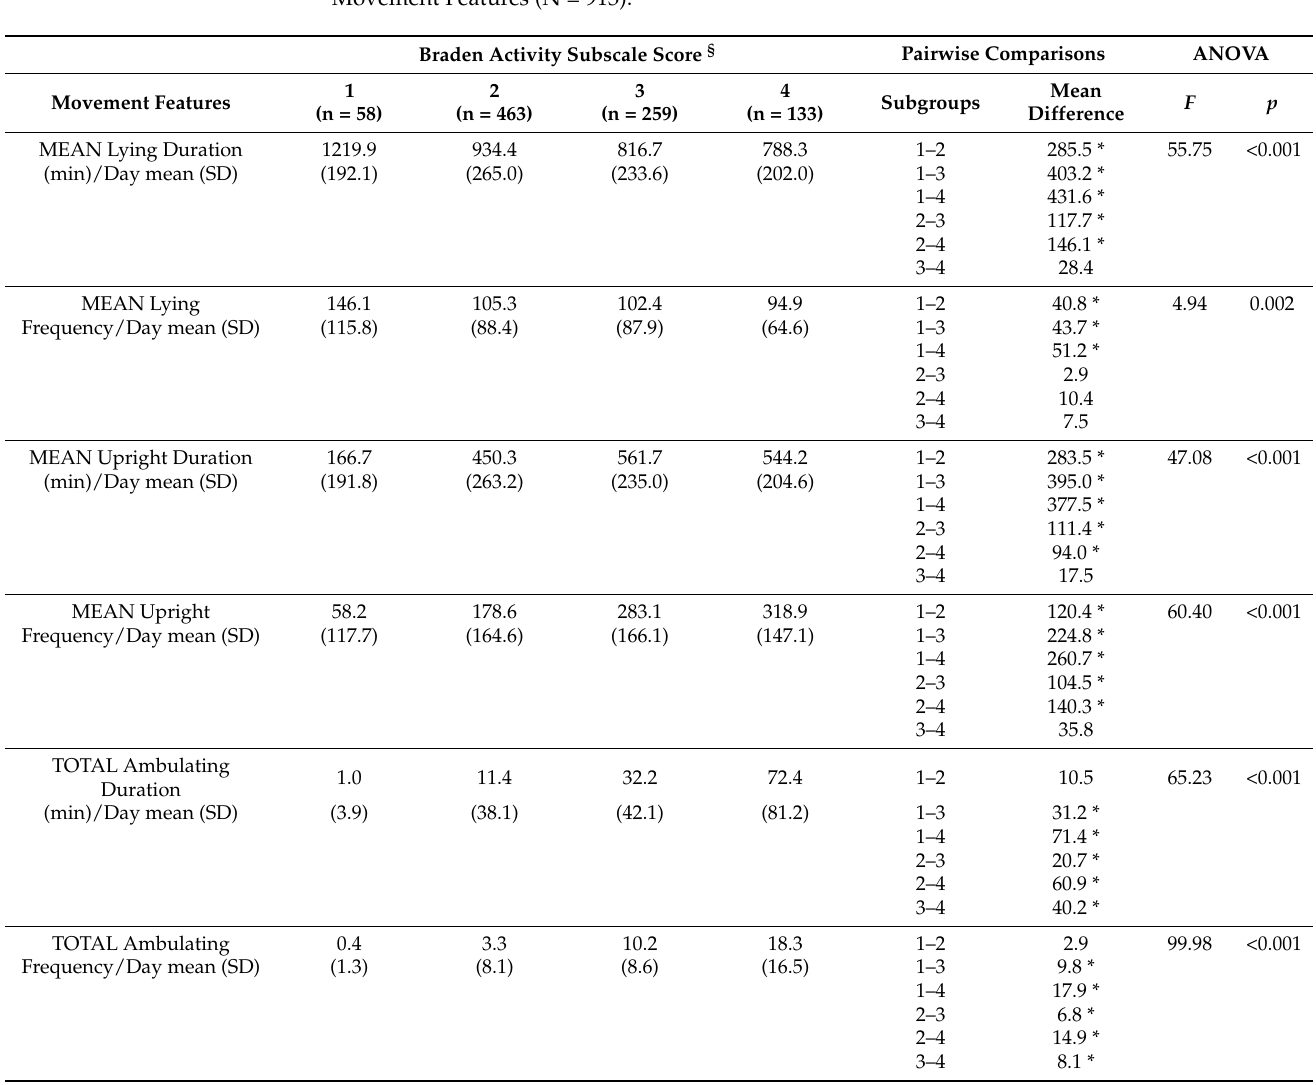
Table 3. Examining Mean Differences Between Braden Activity Subscale Score Groups Relative to Movement Features (N =